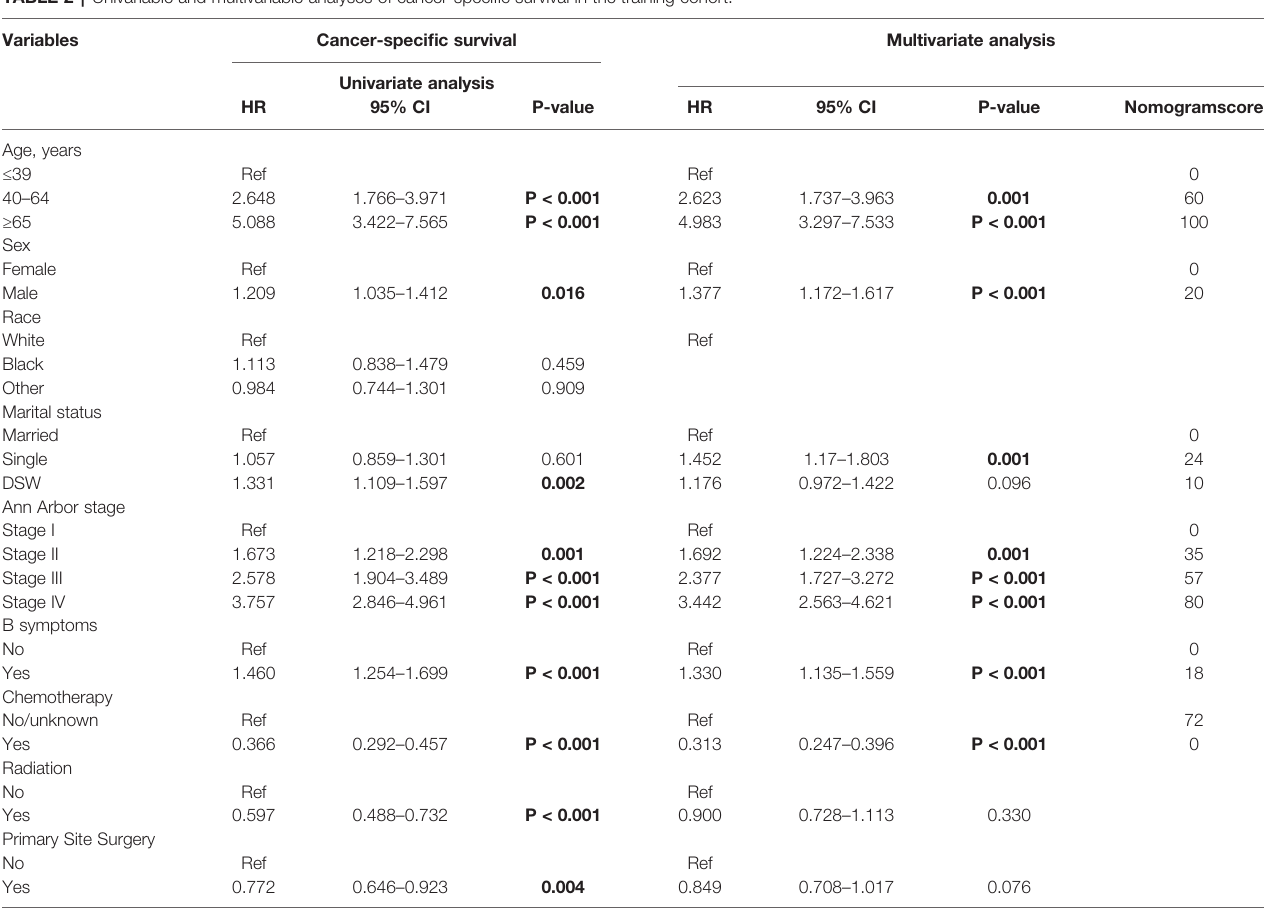
Bold values indicate P<0.05 in univariate analysis and multivariate analysis.